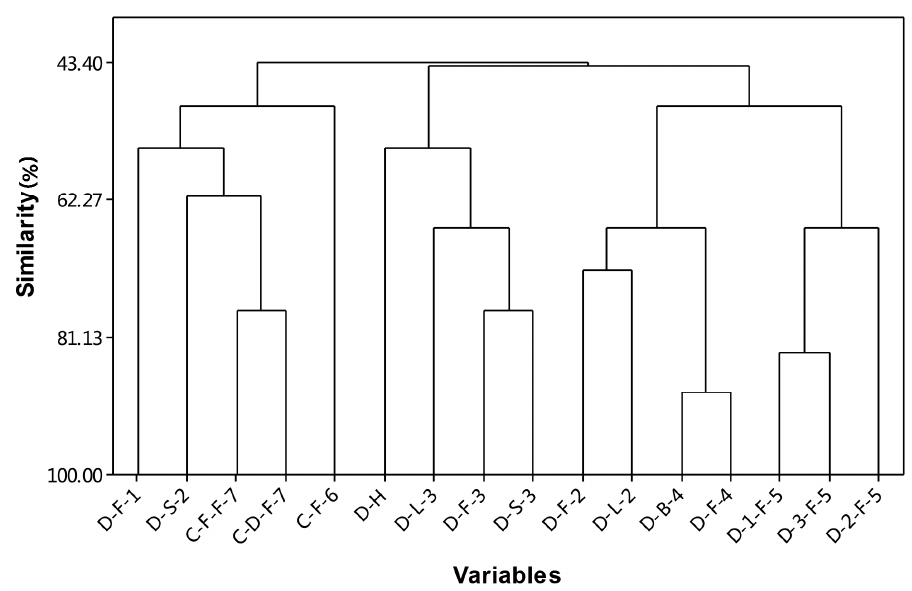
Figure 3. Cluster analysis of our result (D-H) and published GC-MS compositions of the essential oil from different tissues, flower (F), stem (S), leaves (L), whole plant (H), and flower bud (B), D. indicum var. aromaticum (D) and C. indicum (C).1: [9], 2: [5], 3: [10], 4: [11], 5: [4], 6: [12], 7: [13].